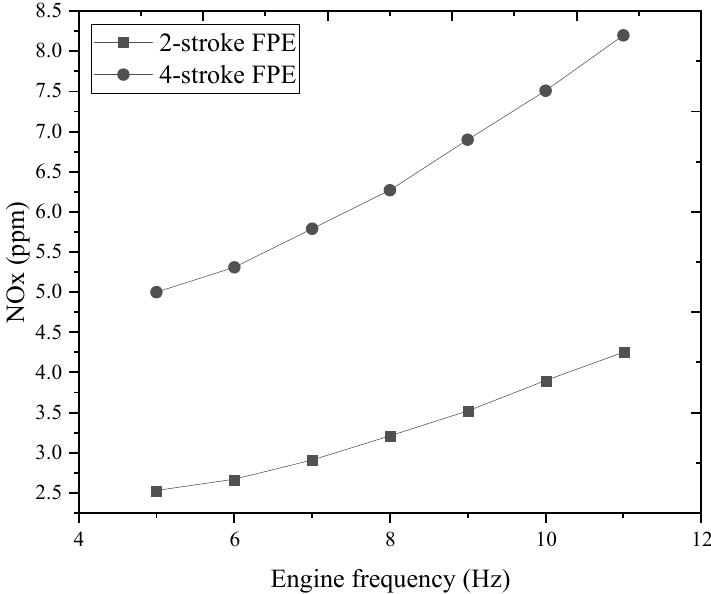
Figure 12. NOx emission comparison between 2- and 4-stroke hydrogen FPE.